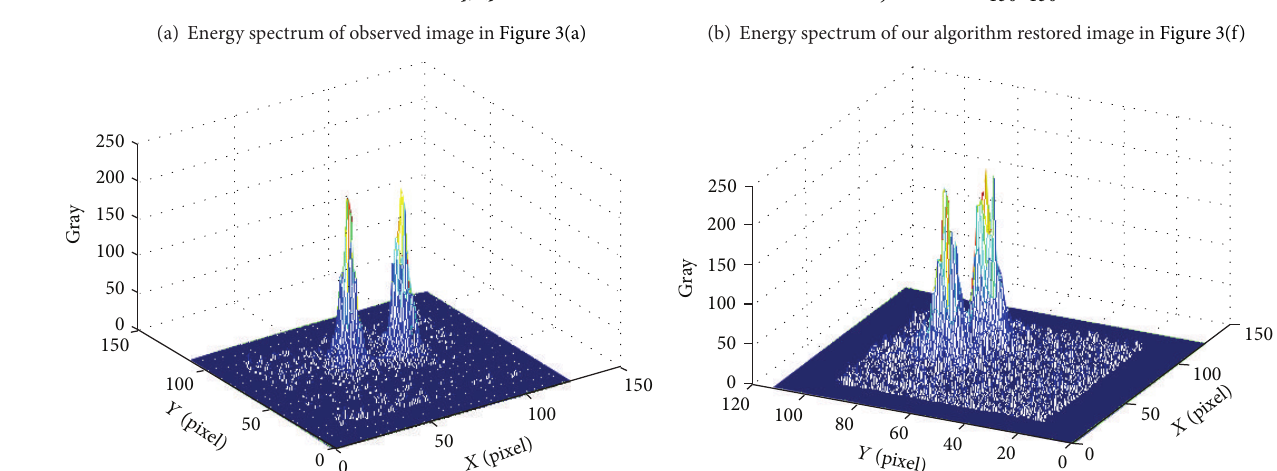
(b) Energy spectrum of our algorithm restored image in Figure 3(f)